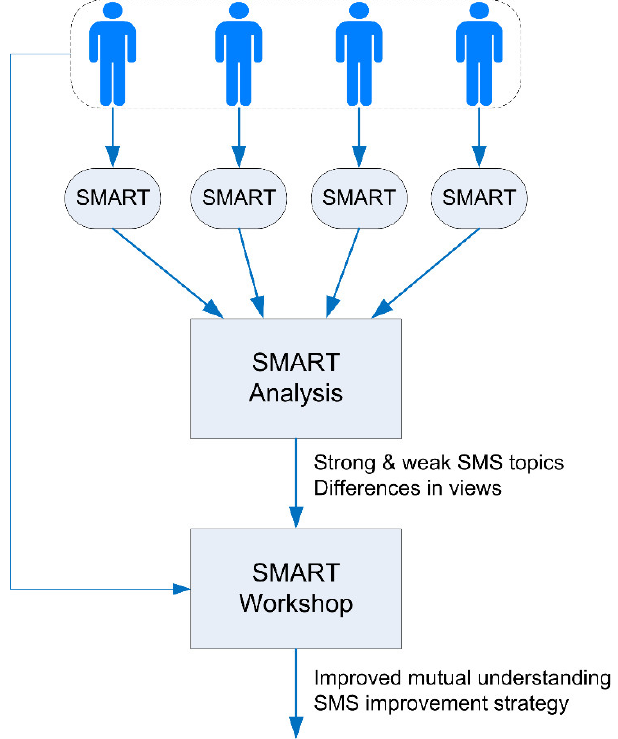
Figure 3. Multiple users–single organisation application scheme of SMART.